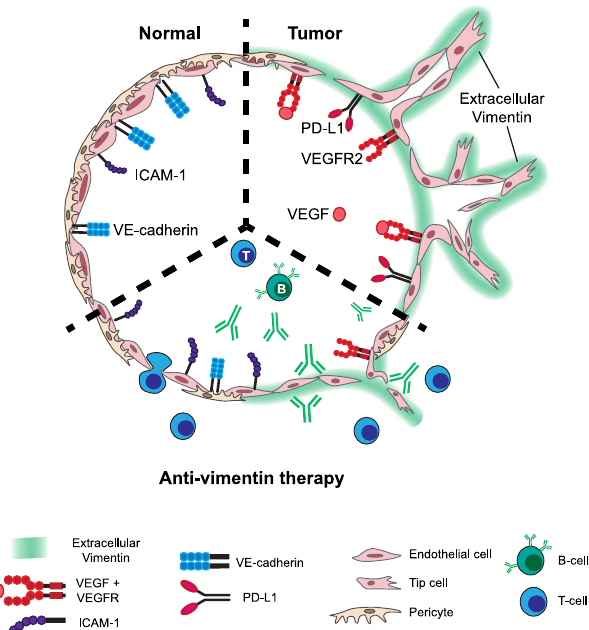
Fig. 7 Anti-angiogenic immunotherapy targeting extracellular